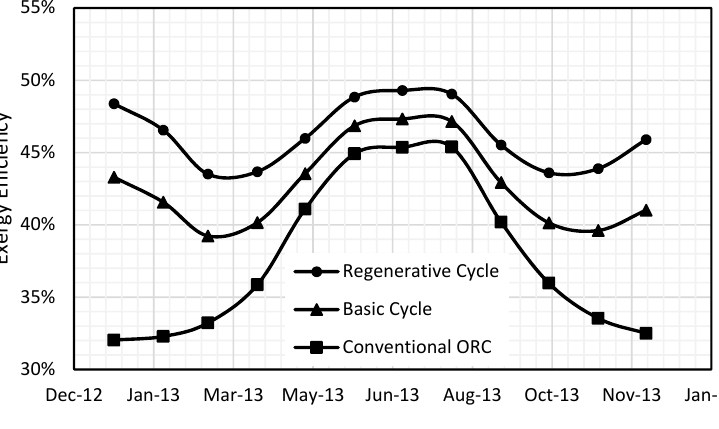
Figure 18. Variation in Exergy Efficiency over the year for a heat source temperature of 75 °C under Beijing’s ambient conditions for the Recuperative, Non-Recuperative, and Conventional (Non-Dynamic) cycles.